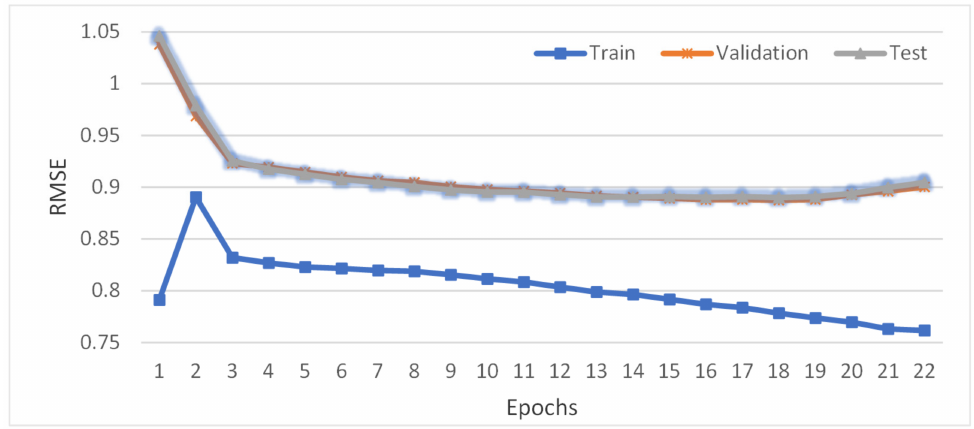
Figure 4. Changes of the RMSE of the training set, cross-validation set, and test set under ML-100k with the number of iterations.